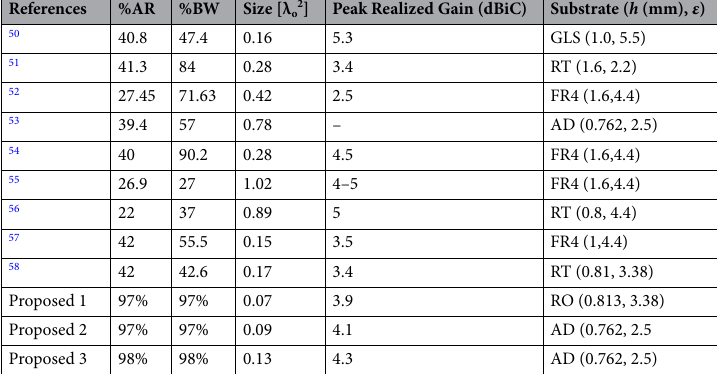
Table 4. Comparison with state-of-the-art CP